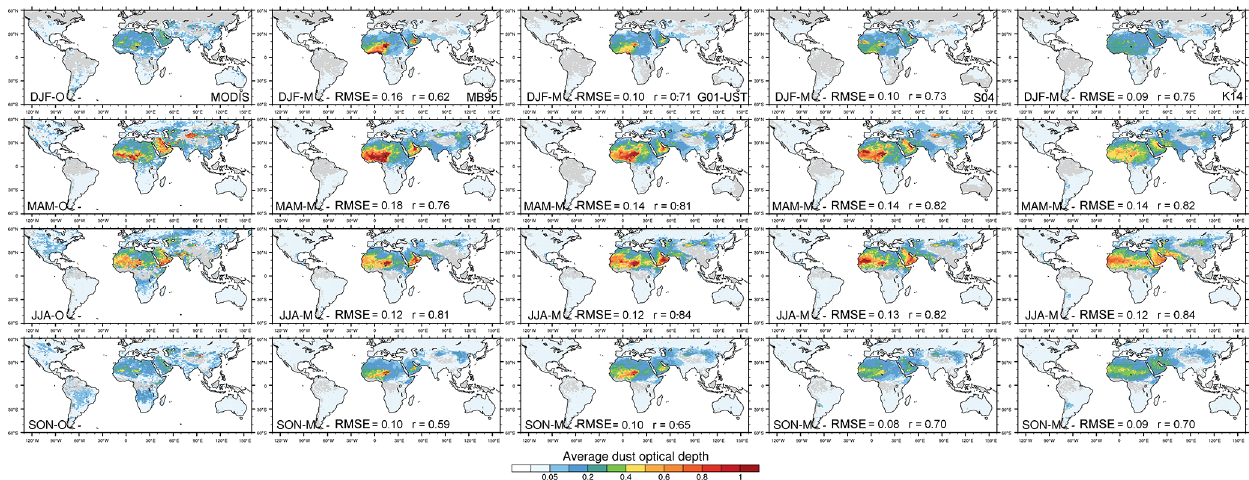
Figure B1. Seasonally averaged MODIS Deep Blue DOD (left) and MONARCH all-sky DOD coarse at satellite overpass times co-located with MODIS DOD for the MB95, G01-UST, S04, and K14 runs. The seasonal averages were calculated with respect to the number of valid values per grid cell in the MODIS product. Area-weighted RMSE and uncentered Pearson product-moment coefficient of linear correlation (r) are indicated in the respective panels.